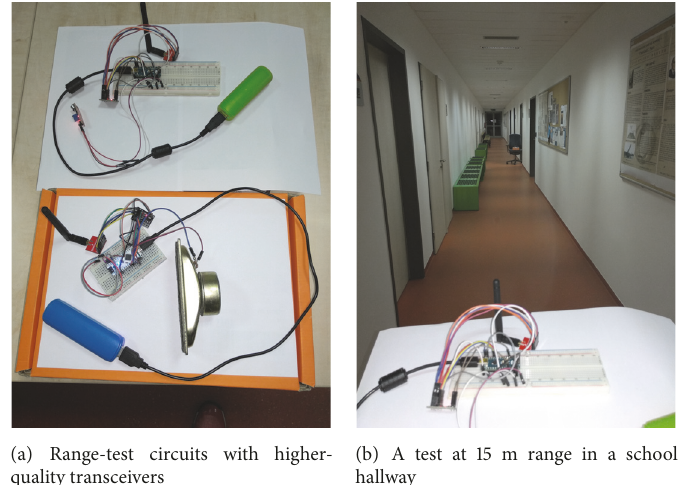
Figure 6: Full-duplex voice communication